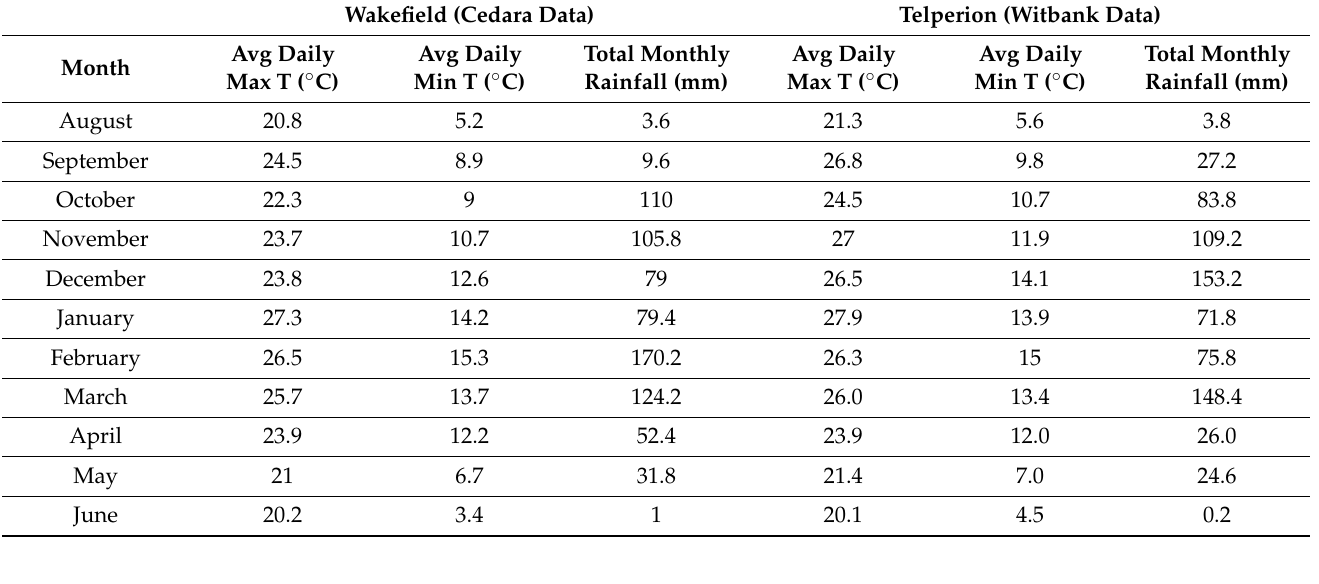
Table 3. Average minimum and maximum temperatures and daily rainfall data between August 2017 and June 2018 for Cedara and Witbank.